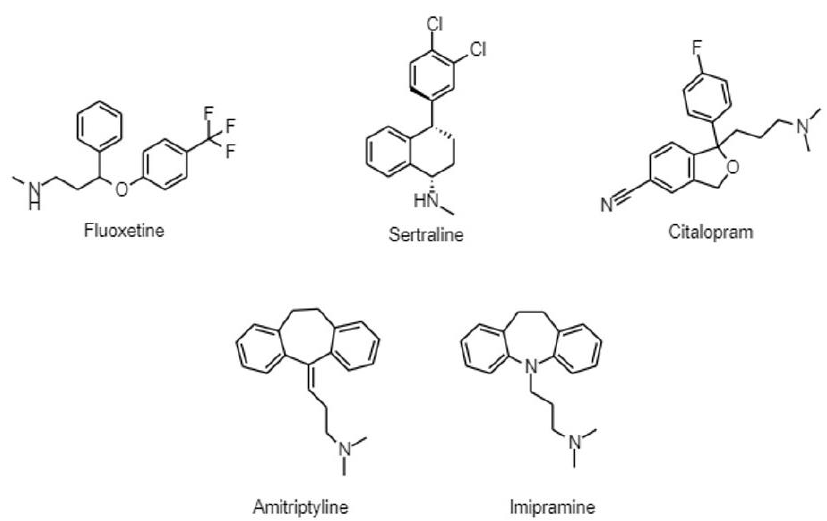
Figure 2. Chemical structures of antidepressants.